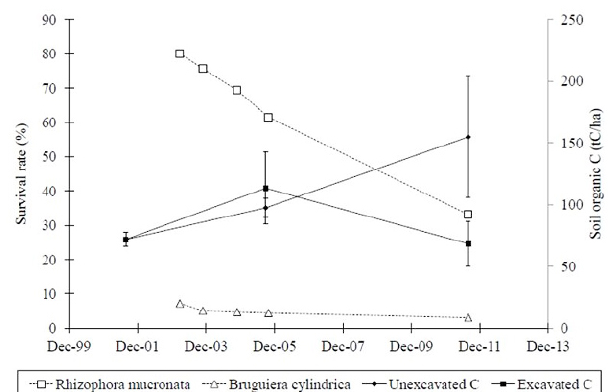
Fig. 3 . The survival rate of 2 mangrove species, Rhizophora mucronata and Bruguiera cylindrica , from 5 months to 10 years after planting. Soil organic carbon (tC/ha) of the excavated and unexcavated area illustrates a decline in carbon in the excavated area (Matsui et al. 2012). Note that the initial increase is likely due to incorporation into the soil of the unsuccessful planted